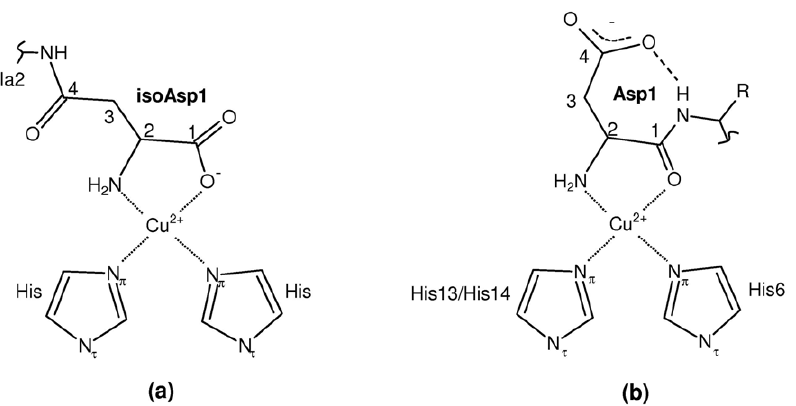
Figure 2. Two-dimensional representation of the 5-membered chelate formed by (a) Cu 2 + /A b 1[isoAsp]–16 and (b) Cu 2 + /A b 1–16 (R = CH 3 ) and Cu 2 + /A b 1–16(A2V) (R = CH 2 (CH 3 ) 3 ), with one possible H-bonding interaction shown. The coordination in (b) only predominates below pH 8, whereas the stable chelate in (a) remains the sole coordination mode (Figure 1).